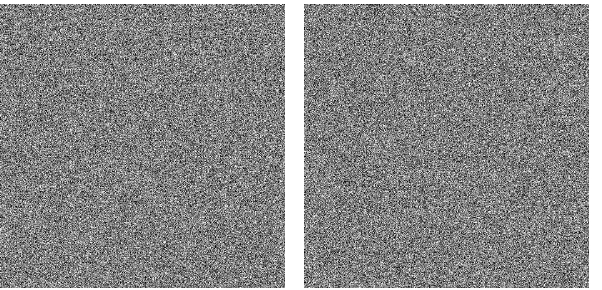
Figure 11. Bitwise XOR between two cipher images C 1 and C 2 resulting from encrypting the Lena image using the proposed scheme with keys K 1 and K 2 ( left ) and K 1 and K (cid:48)